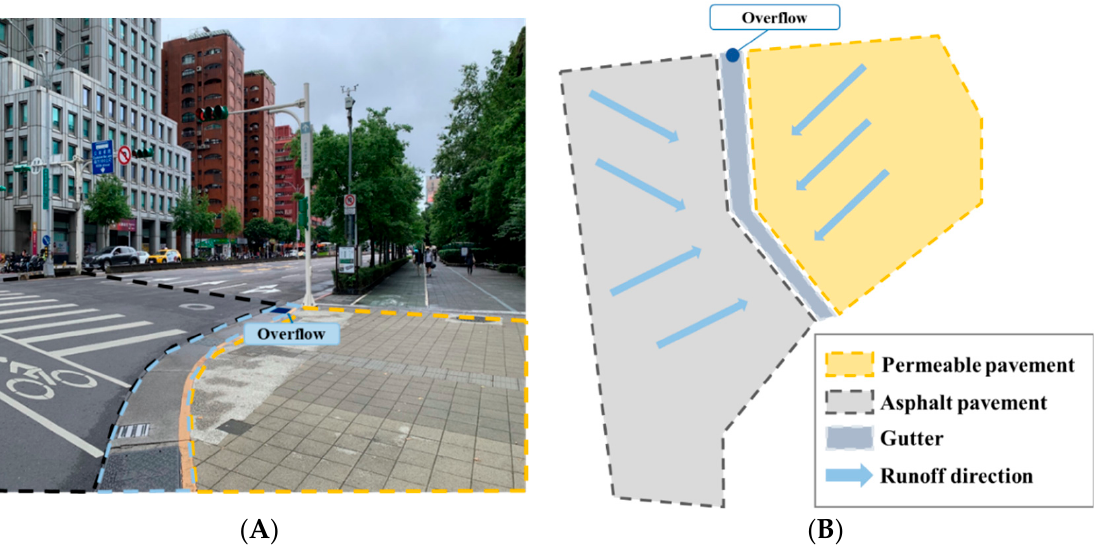
Figure 2. The studied permeable pavement site. ( A ) Site photo and ( B ) sketch of the site area.